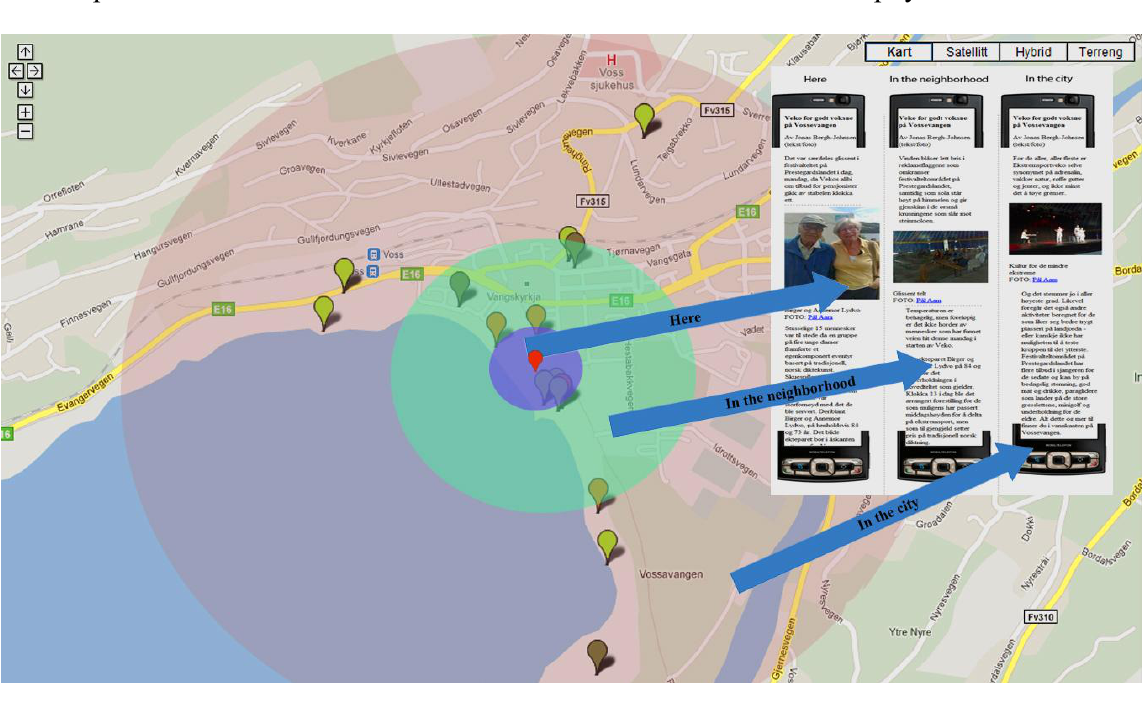
Figure 1. An illustrative picture of the concept and how the different proximity zones correspond to the texts. The red dot in the middle illustrates the reader‟s physical